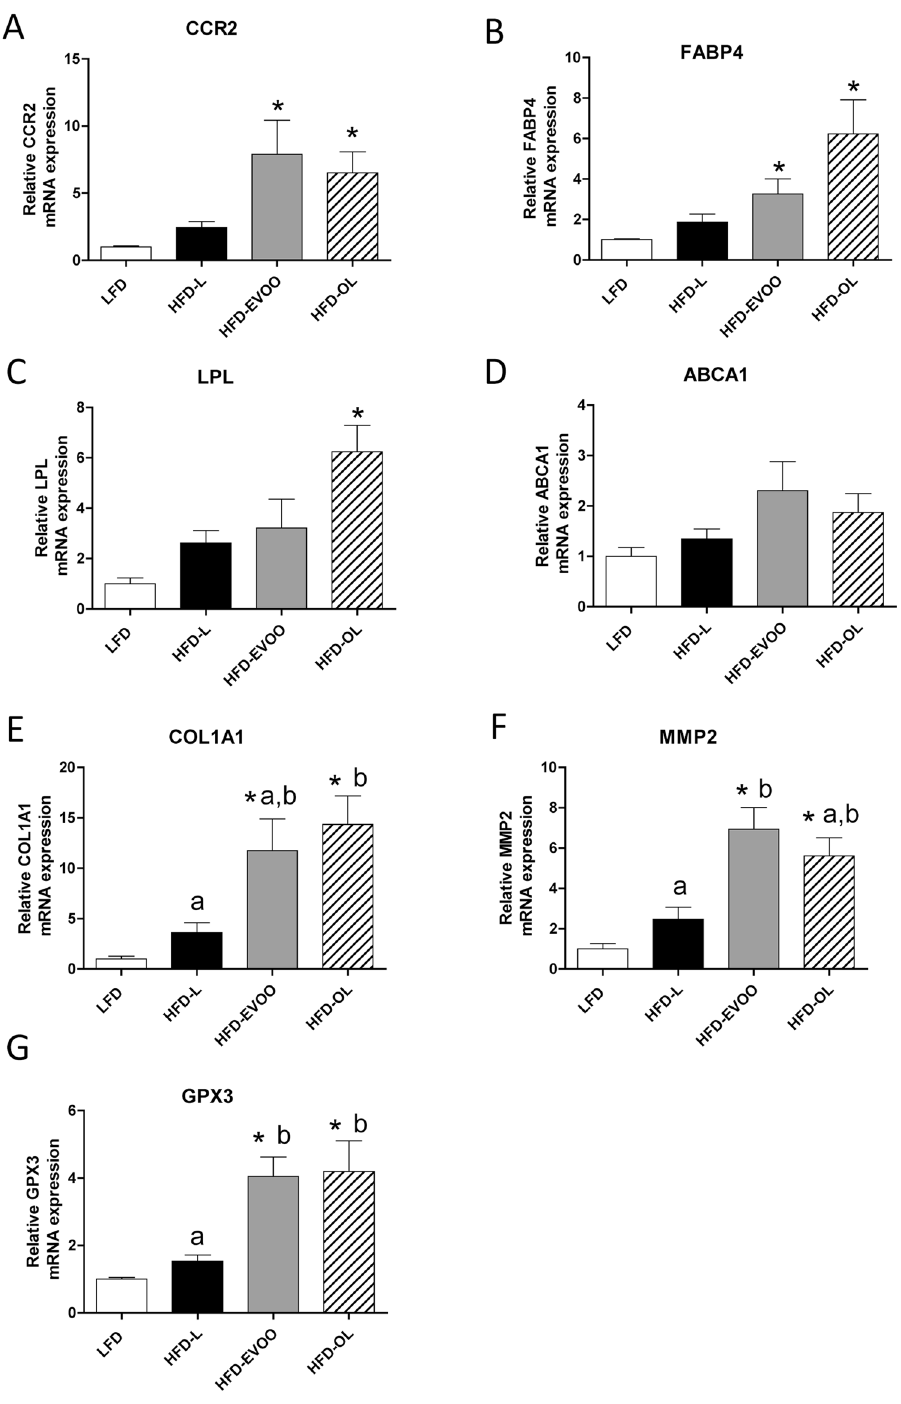
Figure 8. Hepatic mRNA expression of genes involved in inflammation, lipid metabolism, fibrosis and oxidative stress at 32 weeks of nutritional intervention. ( A ) Ccr2; ( B ) Fbpa4; ( C ) Lpl; ( D ) Abca1; ( E ) Col1a1; ( F ) Mmp2 and ( G ) Gxp3. Values are the means ± SEM (n = 3). * p < 0.05 vs LFD; different letters indicate significant differences between HFD groups ( p <